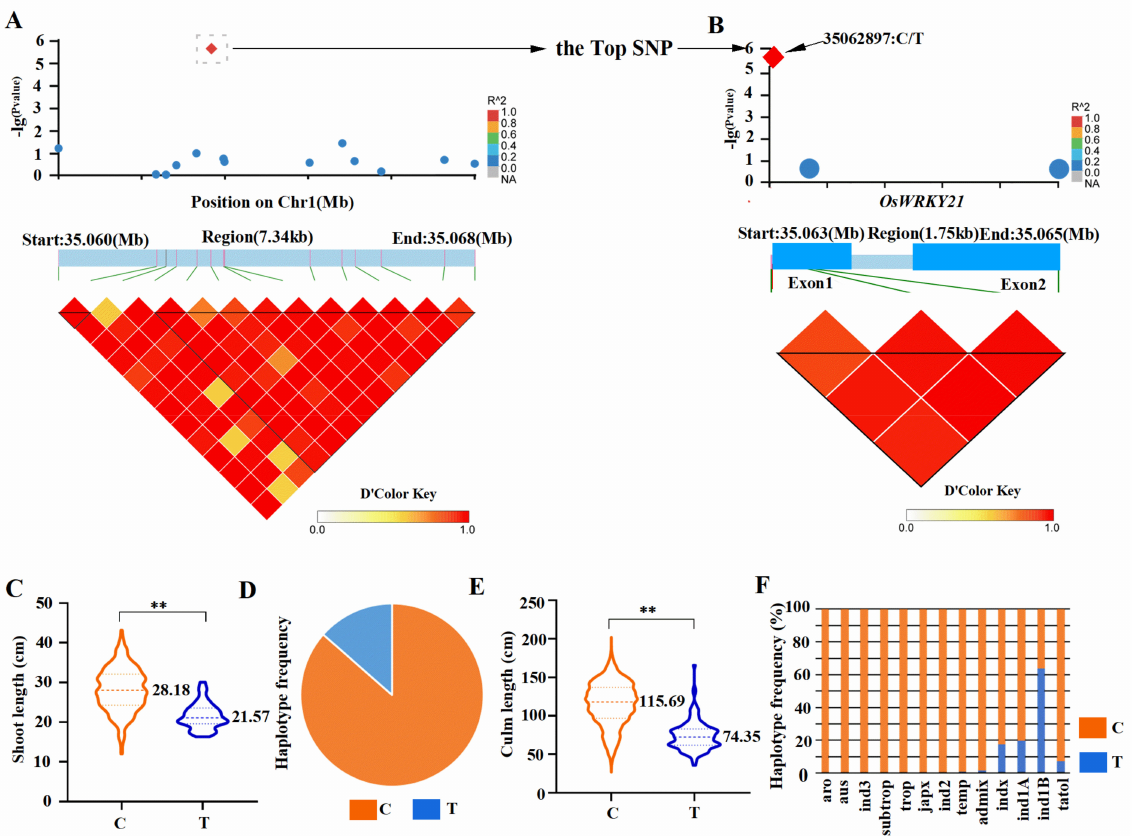
Figure 1. GWAS identification of candidate genes for shoot length at seedling stage ( A – D ) and culm length at heading stage ( E and F ). ( A ) SNPs at the region of 35060000-35368000 on Chromosome1. ( B ) GWAS identification of OsWRKY21 as a candidate gene for shoot length at seedling with the group of Manhattan plots, candidate gene structure, and putative causal polymorphisms (C/T) (the position SNP C/T is indicated by an arrow). ( C ) Shoot length is significantly different between two different haplotypes C and T at p < 0.01 (** indict p -value < 0.01, t -test, n ≥ 20). ( D ) Haplotype frequency of C type and T type in the association panel. ( E ) Culm length is significantly different between two different haplotypes C and T at p < 0.01 (** indict p -value < 0.01, t -test, n ≥ 20). ( F ) Haplotype frequency of C type and T type in the different subpopulation of the association